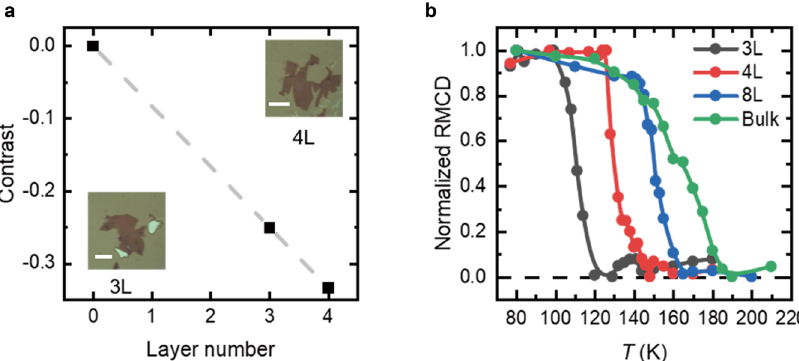
Fig. 1 Optical images, optical contrasts, and the normalized RMCD of few-layer Fe 3 GeTe 2 . a Gray channel optical contrasts and optical images of the 3 L and 4 L Fe 3 GeTe 2 . The optical contrasts of the 3 L and 4 L Fe 3 GeTe 2 follow the linear dependence on layer numbers. The gray dashed line serves as an eye guide. Scale bars in the insets, 5 μ m. b Normalized RMCD of Fe 3 GeTe 2 of different thicknesses. The T C values of the 3 L and 4 L Fe 3 GeTe 2 are at about 120 K and 145 K, similar to the reported values in the previous literature 17 . The error bars are within the symbol